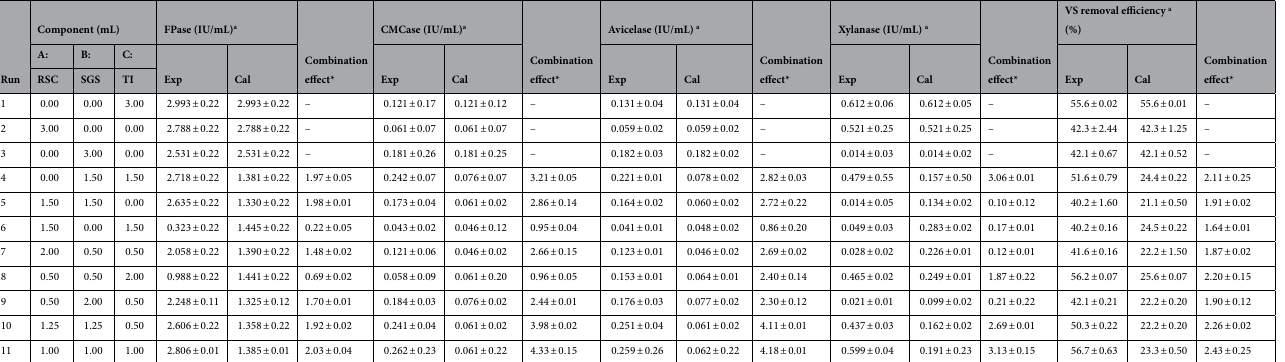
Table 3. Mixture experimental design defining proportions of rice straw compost (RSC), soil around goat and sheep stalls (SGS), and termite intestines (TI) and respective values of FPase, CMCase, avicelase, xylanase, and VS removal efficiency of sugarcane bagasse. Cal. calculation, Exp. experimental. *Co-digestion effect > 1 indicates a synergistic effect. *Co-digestion effect = 1 indicates no effect. *Co-digestion effect < 1 indicates an antagonistic effect. a The experimental enzyme activity or VS removal efficiency represents the total amount of enzyme activity or VS removal efficiency generated in each proportion from the cultivation process, and the calculated enzyme activity or VS removal efficiency was calculated from the enzyme activity or VS removal efficiency of the individual substrates in each microorganism source (based on mL) contained in the